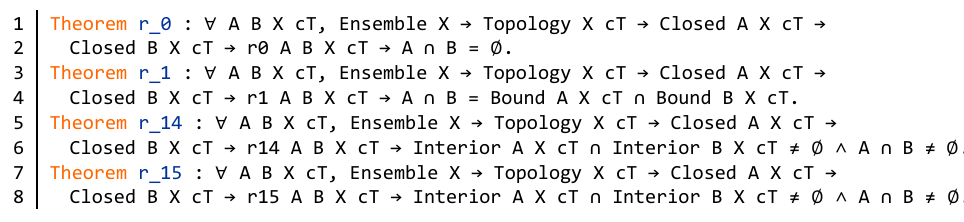
Figure 7. The formal description of Theorem 3 ( r 0 , r 1 , r 14 , r 15 ).